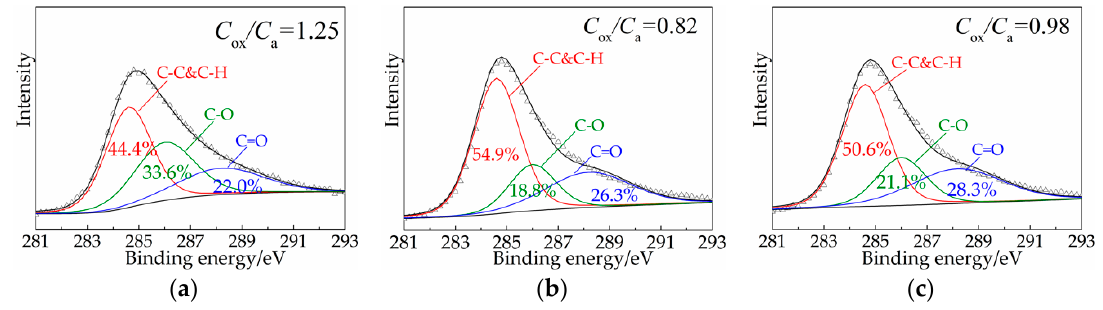
Figure 9. Digital and SEM images of the residues after cone calorimeter tests.